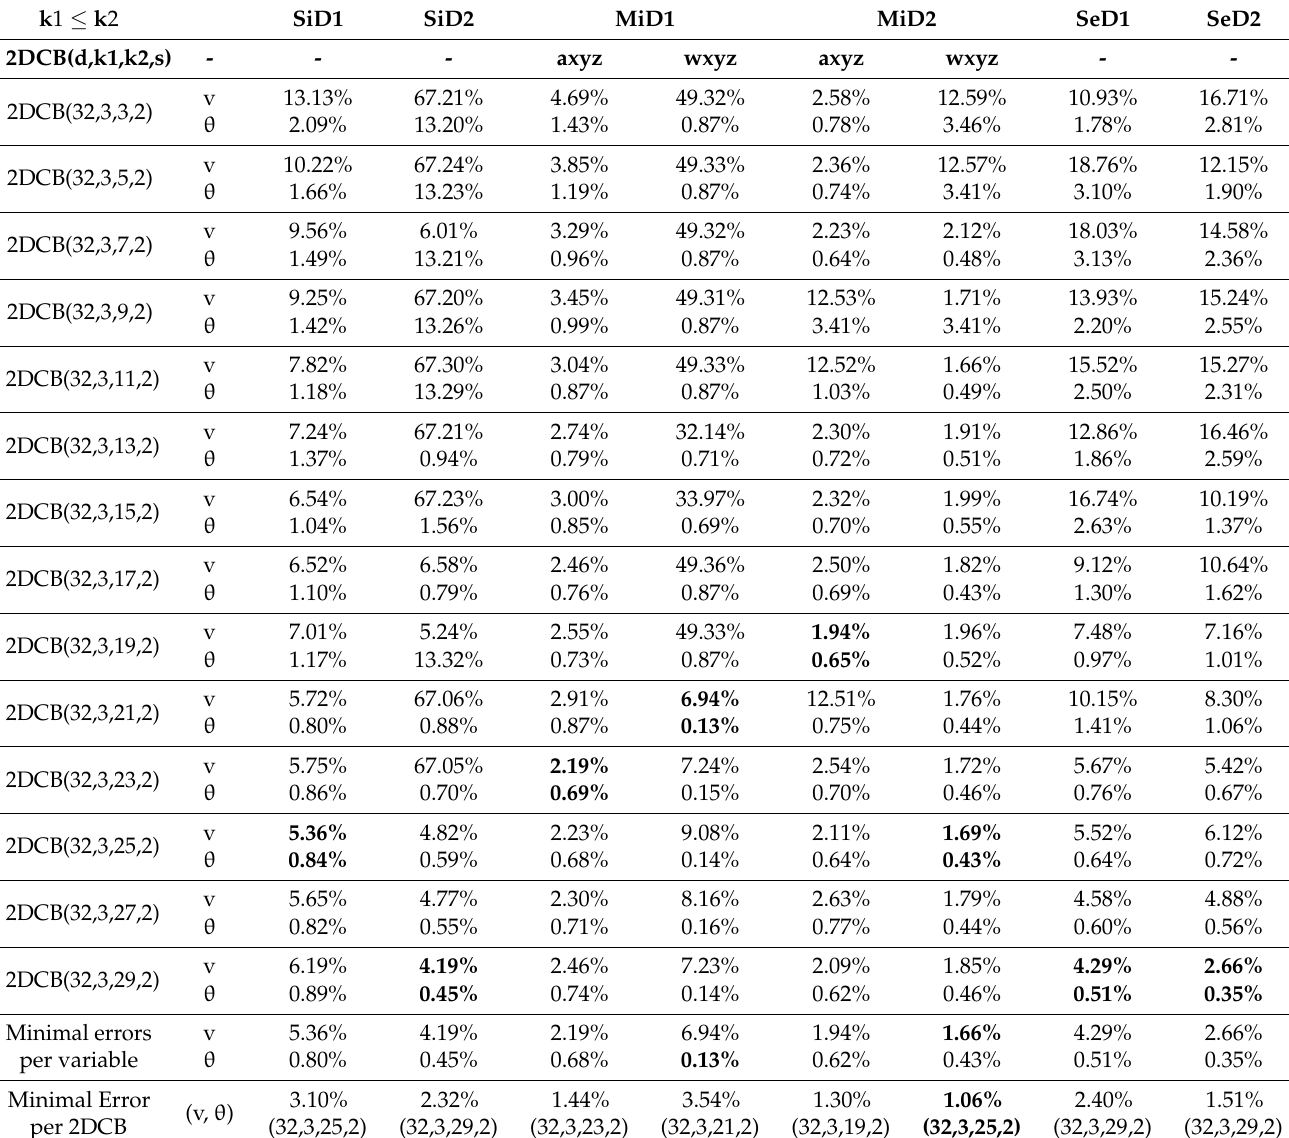
Table 4. MAPE obtained during the 2DCB optimization k1 ≤ k2 for the architectures. Bold texts show the best